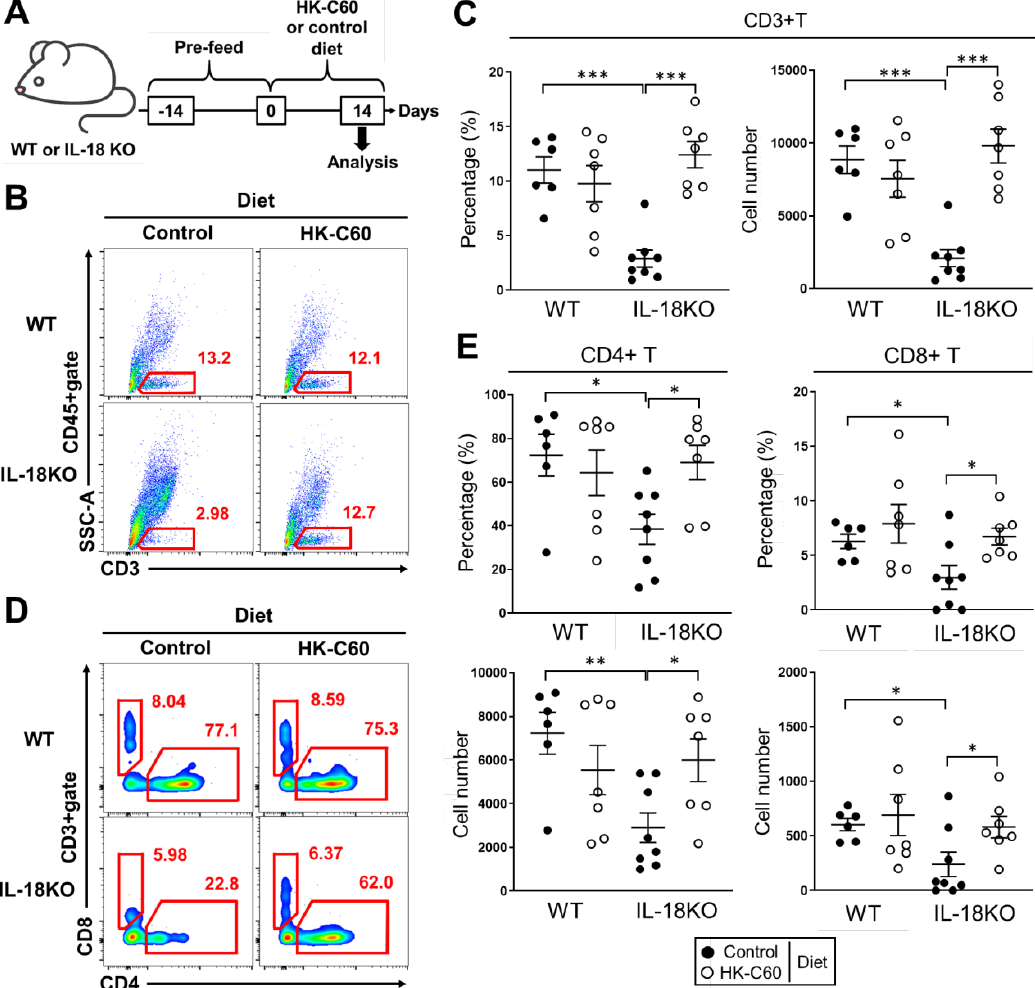
Figure 1. T cell population which specifically decreased in small intestinal lamina propria (SI-LP) is recovered by HK-C60 diet in aged IL-18KO mice. ( A ) The design of diet in WT and IL-18O aged mice. The mice were fed with control diet for 2 weeks for habituation, then were further fed with HK-C60 or control diet for 2 weeks. After the diet, the mice were used for analysis. ( B – E ) The Characterization of T cell population in SI-LP. The isolated SI-LP cells were analyzed by flow cytometry. The representative image of CD3 + T cells in CD45 + gate ( B ), CD4 + and CD8 + T cells in CD45 + CD3 + gate ( D ). The percentage of CD3 + T cells in CD45 + gate ( C , left), CD4 + and CD8 + T cells in CD45 + CD3 + gate ( E , upper). The cell number of CD3 + T cells in CD45 + gate (per 10 5 ) ( C , right), CD4 + and CD8 + T cells in CD45 + CD3 + gate (per 10 4 ) ( E , lower). The data were shown as the representative or mean ± SEM of at least six samples in three independent experiments. Each dot indicates the data from one sample. A Mann–Whitney U test was used to analyze data for significant differences. Values of * p < 0.05, ** p < 0.01, and *** p < 0.001 were regarded as significant.